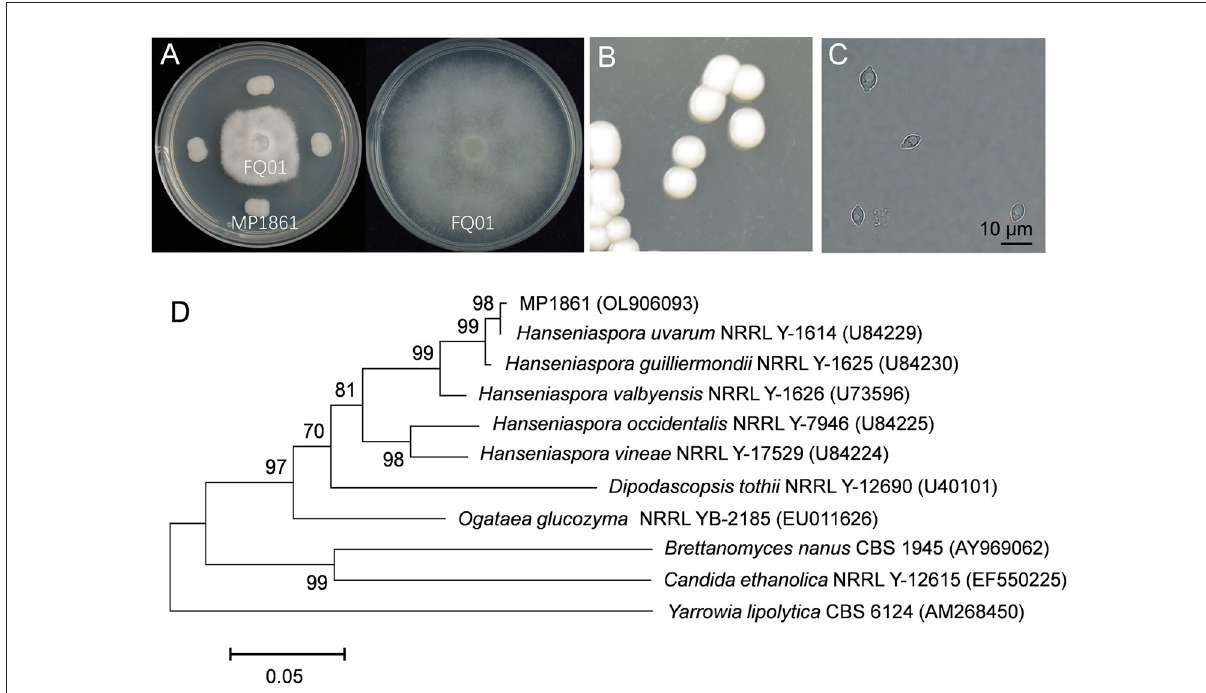
FIGURE2 Identification of the antagonistic yeast strain MP1861. (A) Inhibition of Phytophthora growth by the yeast strain MP1861. (B) Colonies of the yeast strain MP1861 after growth on YPD plates at 26 ◦ C for 2 d. (C) Cell morphological characteristics of the yeast strain MP1861. (D) Phylogenetic relationship of the yeast strain MP1861 and other yeasts according to a neighbor-joining analysis of D1/D2 26S rDNA region.